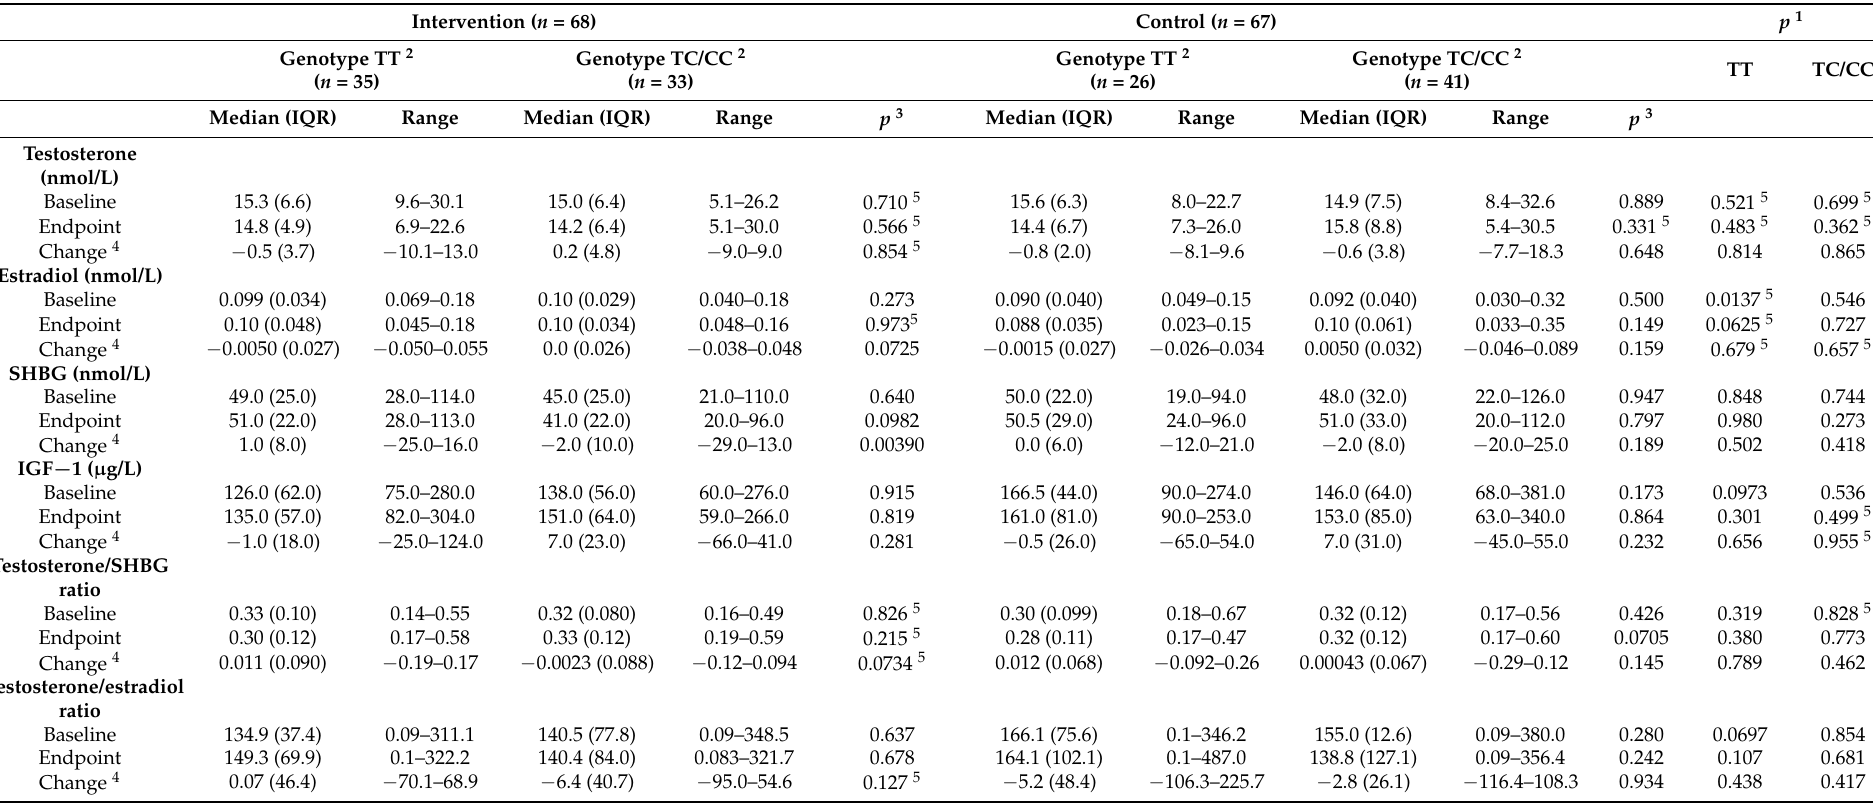
Table 2. Serum concentrations of hormones in the intervention and control groups in patients with prostate cancer, stratified by the genotype of estrogen receptor